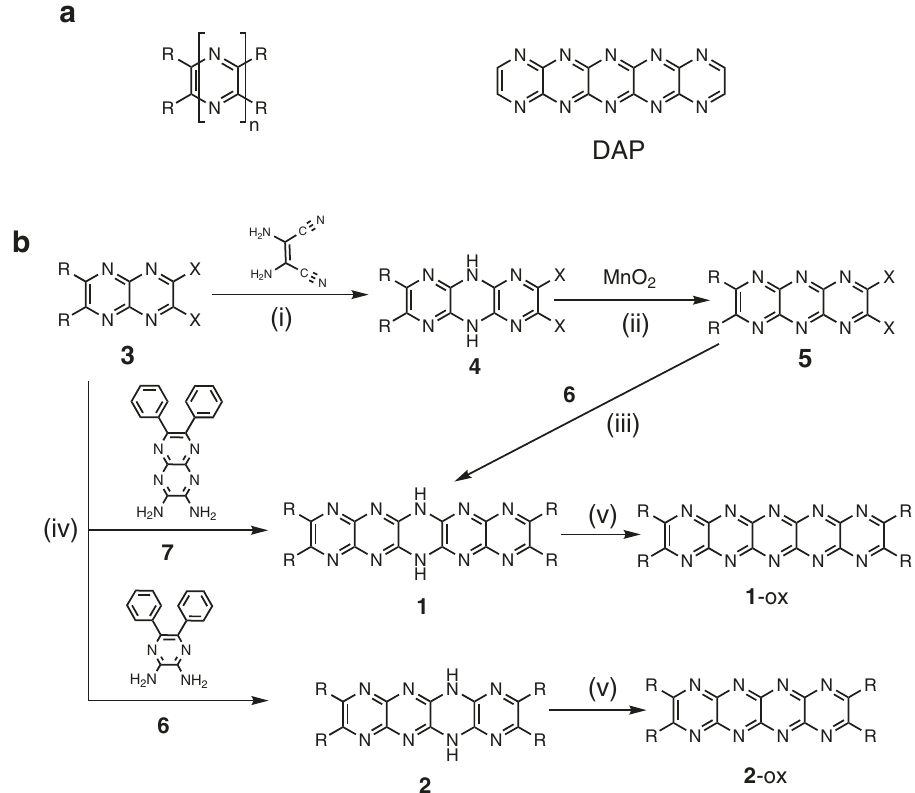
Fig. 1 Chemical structures and synthesis of pyrazinacenes. a General formula for pyrazinacenes and structure of decaazapentacene. b Synthesis of 1 and 2 used in this work. R = C 6 H 5 ( 1 , 2 ), 4-tBuC 6 H 4 ( 1 -tBu); X = nitrile or chloride. Reaction conditions: (i) DMSO, Na 2 CO 3 , 90 °C, 4 h, 47% (ii) CCl 4 :MeCN:H 2